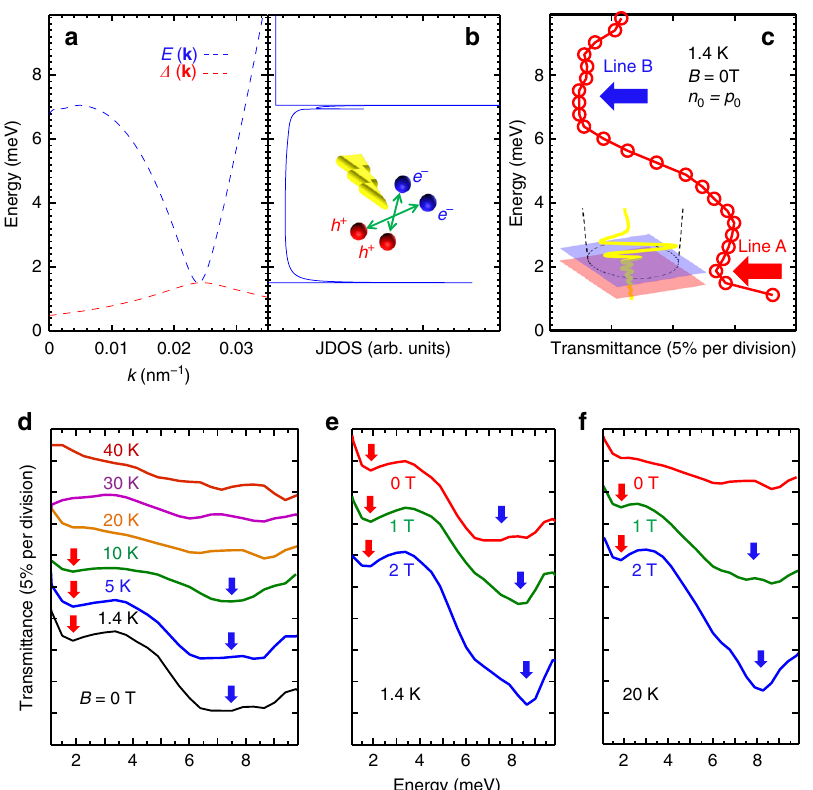
Fig. 2 Pair-breaking excitation spectra of excitonic insulator. a Gap function Δ ( k ) (red dashed line) and the pair-breaking energy E ( k ) (blue dashed line) of the exciton as a function of k for V b = 0 V. b Joint density of states as a function of energy. Inset fi gure: pair-breaking induced by THz light (Blue dots: electrons. Red dots: holes. Yellow arrow: THz light). c Transmission spectrum at the CNP at 1.4 K and 0 T for V b = 0 V. In the inset fi gure, the purple layer represents the InAs quantum-well, whereas the red layer represents the GaSb quantum-well. The yellow wave indicates the THz light, and the dashed black circle marks the lateral extent of the focused THz beam at the sample position. The gate and contacts are not drawn here. d Transmittance spectra at various temperatures at 0 T. e , f Transmittance spectra at different magnetic fi elds at 1.4 and 20 K, respectively. The spectra are vertically offset for clarity. The measurement uncertainty in THz energy is ± 0.2